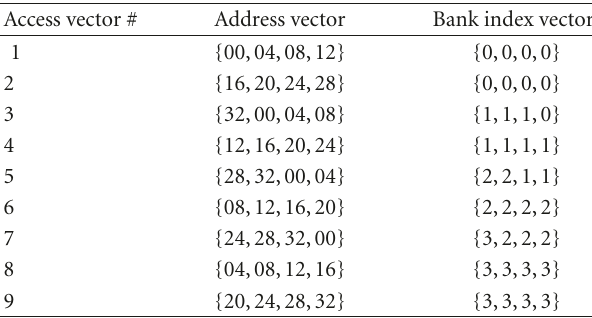
Table 11: Access vector sequence for bank